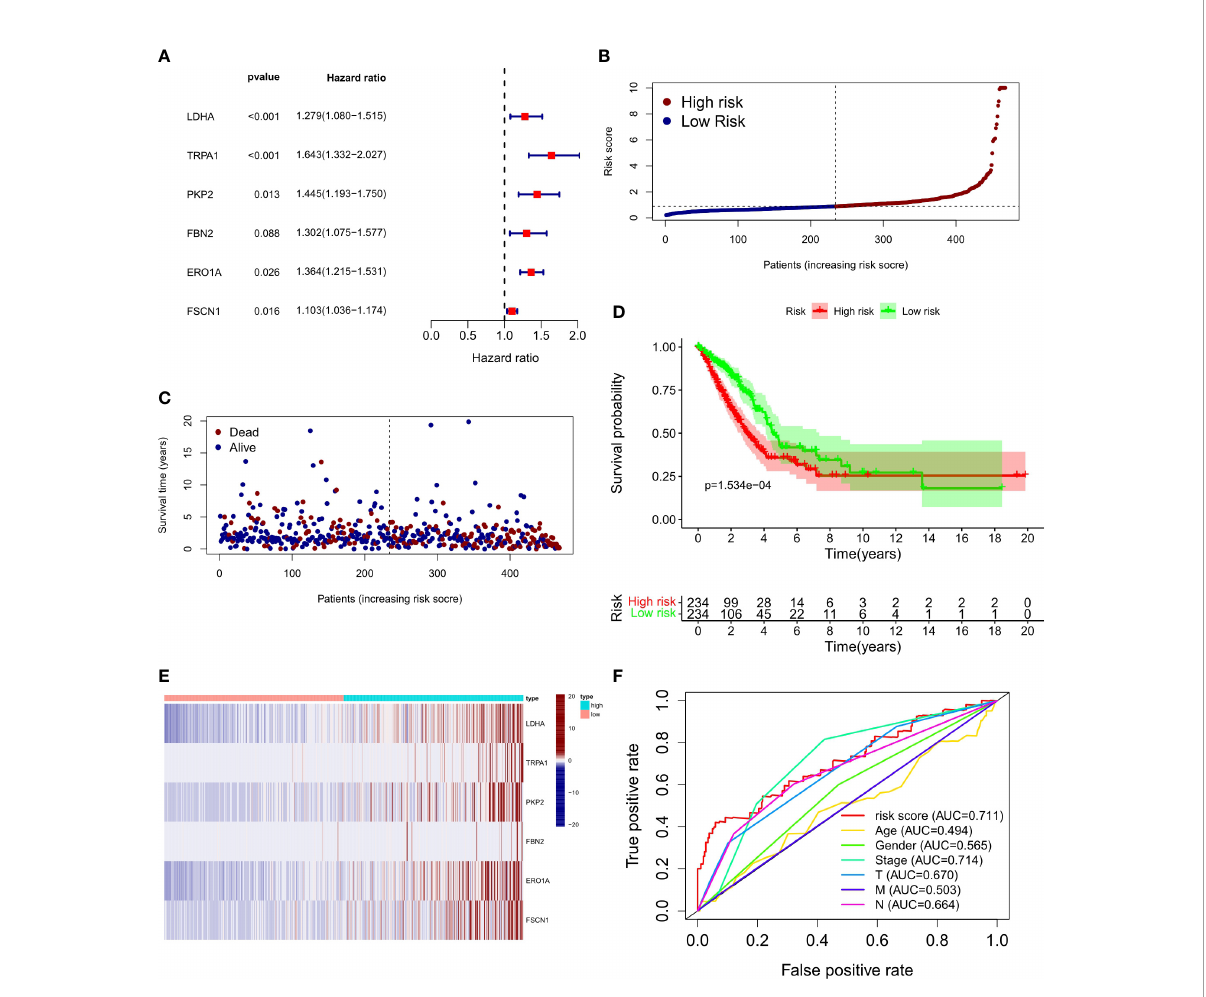
FIGURE 3 Prognostic value of CRC/COVID-19 associated genes. (A) Partial presentation of prognostic related genes identi fi ed by univariate Cox analysis. (B) Distribution of patients based on the risk score. (C) The survival status for each patient (low-risk population: on the left side of the dotted line; high-risk population: on the right side of the dotted line). (D) Kaplan-Meier curves for the OS of patients in the high- and low-risk groups. (E) Expression of LDHA, TRPAI, PKP2, FBN2, ERO1A and FSCN1 in high and low risk groups. (F) ROC curves demonstrated the predictive ef fi ciency of risk scores and clinical